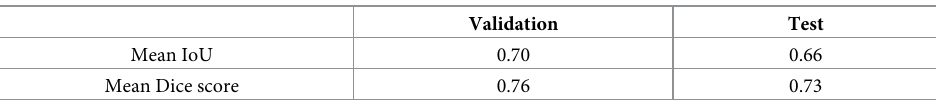
Fig 6. Representative images of cases showing prediction failure by our AI. The panels on the left (A, D, G) show IVUS images. The middle panels (B, E, H) show ground truth mask images that were manually segmented corresponding to IVUS images on the left in the same row. The panels on the right (C, F, I) show label images predicted by our AI corresponding to IVUS images on the left in the same row. In the mask images, the green area shows the lumen area, the red area shows the medial plus plaque area, the orange area shows calcification, the blue area shows a stent, and the black area is background. Two lumina were delineated in panel C because of misidentification of the coronary vein in panel A as the lumen of the coronary artery (blue arrowhead). The lumen edges in panel F were incorrectly delineated because of an artifact of the wire in panel D (pink arrowhead). The stent struts in panel I were misidentified as calcification (yellow arrowhead). https://doi.org/10.1371/journal.pone.0255577.g006 Table 1. Results of the validation and test